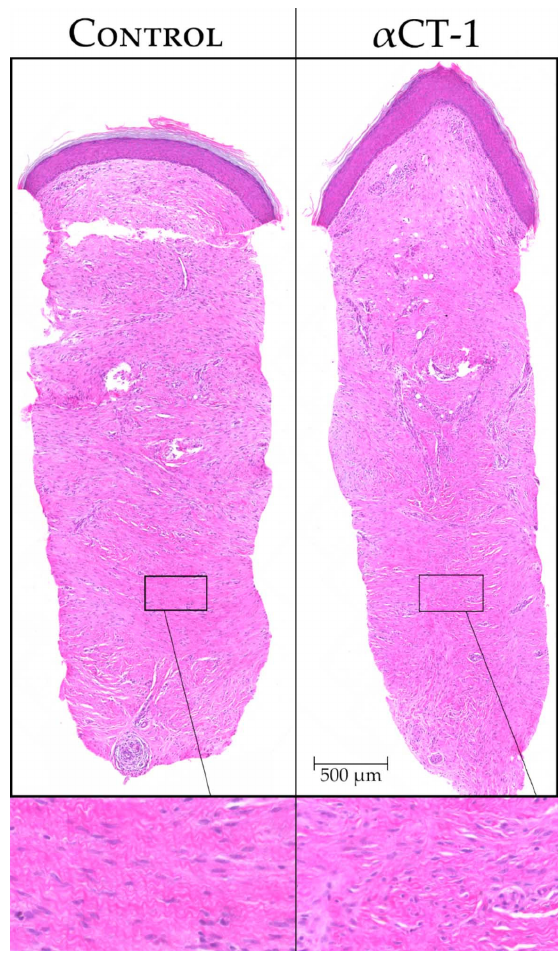
Figure 4. H&E stained whole sections of Phase I biopsies from a single patient at 29 days post-wounding. The left arm was treated with a vehicle ( left ), while the right arm was treated with 100 µM α CT1 ( right ). The boxed regions highlight areas of subtle variance in tissue organization deep within the dermis between the control and treated scars—magnified 4.67× from upper panels.